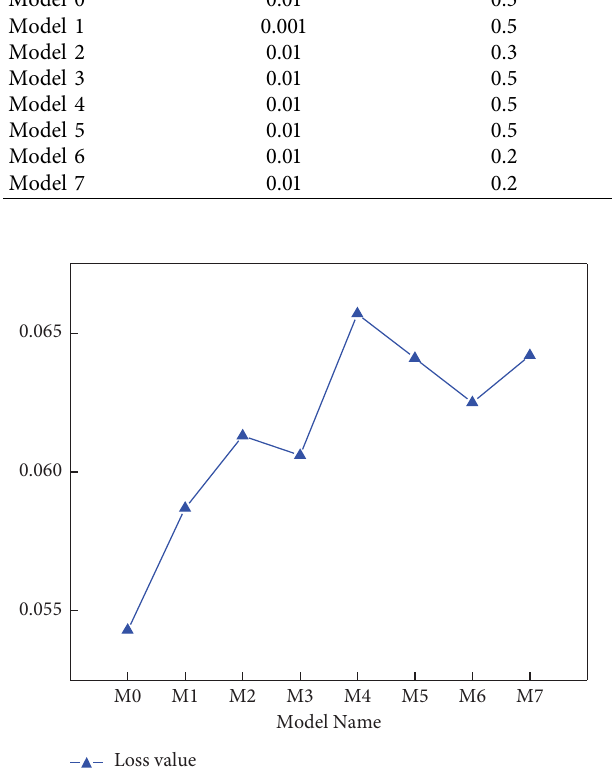
Figure 8: Comparison of loss values with diferent